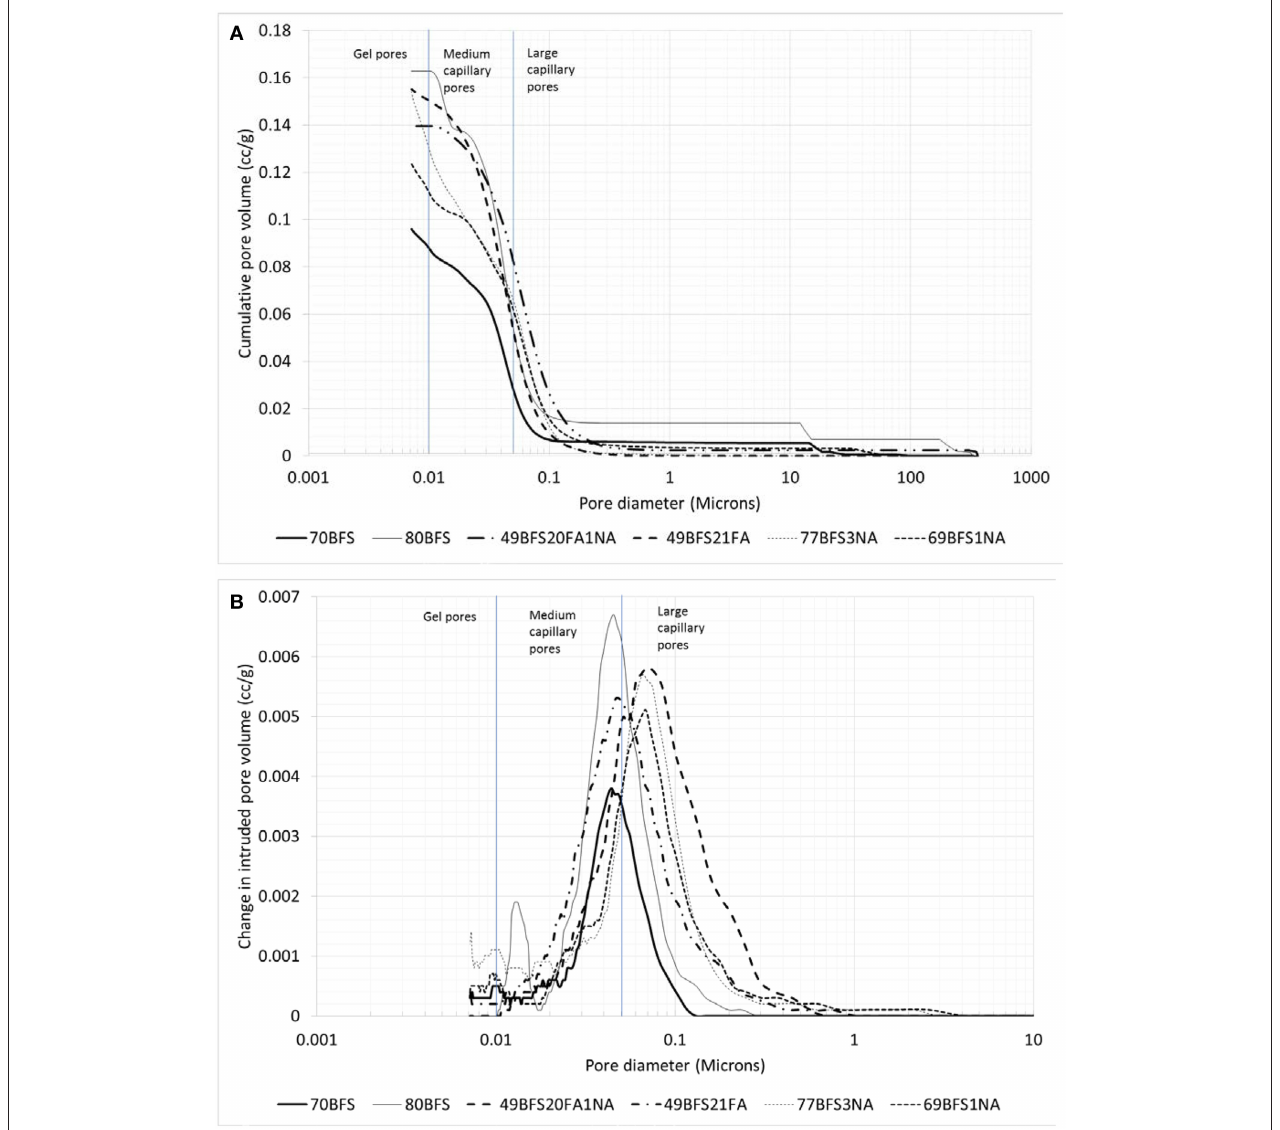
FIGURE 5 | Cumulative pore volume (A) and pore size distribution (B) of HVS and HVS-FA pastes with and without nano